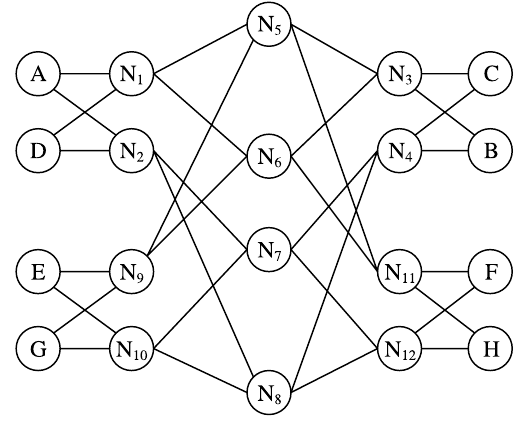
Fig. 1 Data centre network Fat-tree